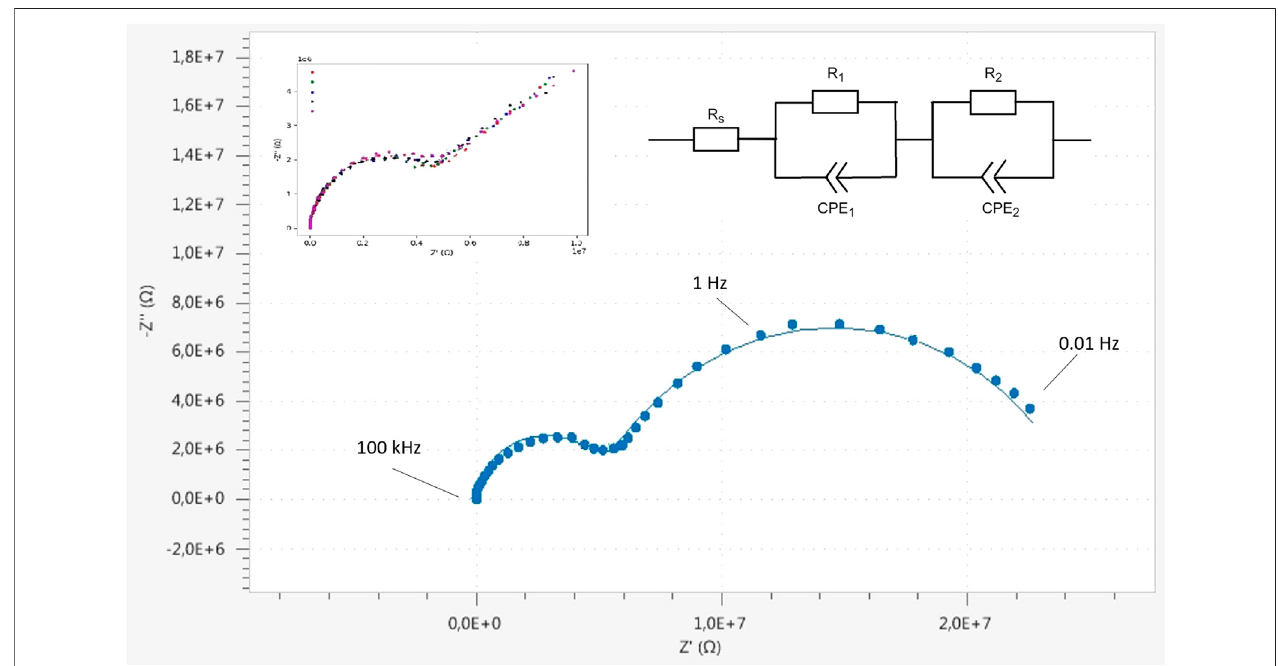
FIGURE11| Impedancemeasurementwithioniccontactvialiquidelectrolyte(1MLiPF6in1:1EC/DMC)betweenthelithiatedtipandametalliclithiumsample.The measurement (00.1 Hz – 100 kHz)consistoftwosemicircleswhichcan bedescribed withthe equivalent circuit (topright) . Calculated values(NOVA circuit fi t, Metrohm Autolab)areRs (cid:1) 600 Ω ;R1 (cid:1) 19.5 M Ω ;CPE1 (cid:1) 14.6 nFand n (cid:1) 0.79;R2 (cid:1) 4.95 M Ω ;CPE2 (cid:1) 252 pFand n (cid:1) 0.96.Fiveshortmeasurements(1 Hz – 100 kHz, top-left) show the reproducibility of the measurement